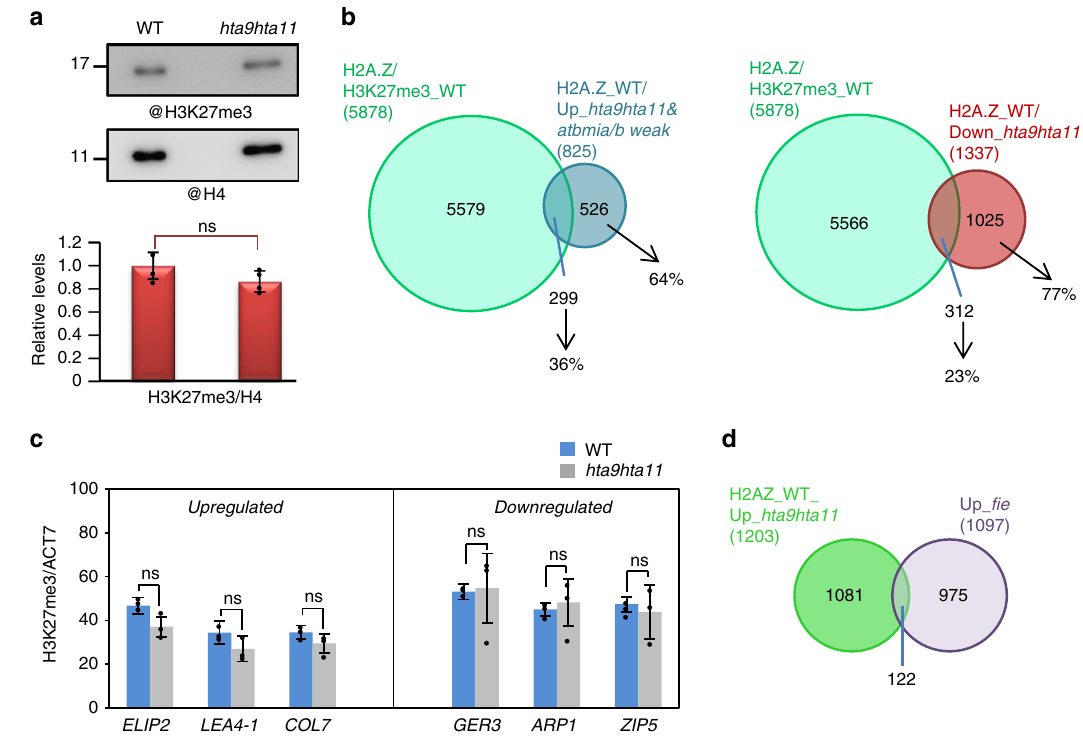
Fig. 5 H2A.Zub repressive effect is independent of Polycomb Repressive Complex 2 activity. a Western blot showing global H3K27me3 levels in wild-type (WT) and hta9hta11 mutants at 7 days after germination (DAG). The same blot was probed with anti-H4 antibody for loading control. Bottom bar chart shows quanti fi cation of H3K27me3 levels relative to H4. Error bars indicate standard deviation of n = 4 independent experiments. Data points are indicated in the bar charts. No signi fi cant (ns) differences between WT and hta9hta11 were found according to Student ’ s t test. b Left panel, Venn diagram showing the percentage of upregulated genes in hta9hta11 and atbmi1a/b weak that were enriched in H2A.Z and H3K27me3 marked in WT (H2A.Z/H3K27me3_WT) at 7 DAG. Right panel, Venn diagram showing the overlap between genes downregulated in hta9hta11 and H2A.Z/H3K27me3_WT genes. c H3K27me3 levels analyzed by chromatin immunoprecipitation – quantitative polymerase chain reaction at ATG surrounding region of several upregulated and downregulated genes in hta9hta11 that were H2A.Z/H3K27me3_WT (genes from overlaps of b ). The levels were normalized to ACTIN7 ( ACT7 ). Error bars indicate standard deviation of n = 3 biological replicates. Data points are indicated in the bar charts. No signi fi cant (ns) differences between WT and hta9hta11 were found according to Student ’ s t test. d Venn diagram showing the overlap between the H2A.Z-enriched genes that are upregulated in hta9hta11 and the ones upregulated in fi e mutants. Source data of Fig. 5a, c are provided as a Source Data fi